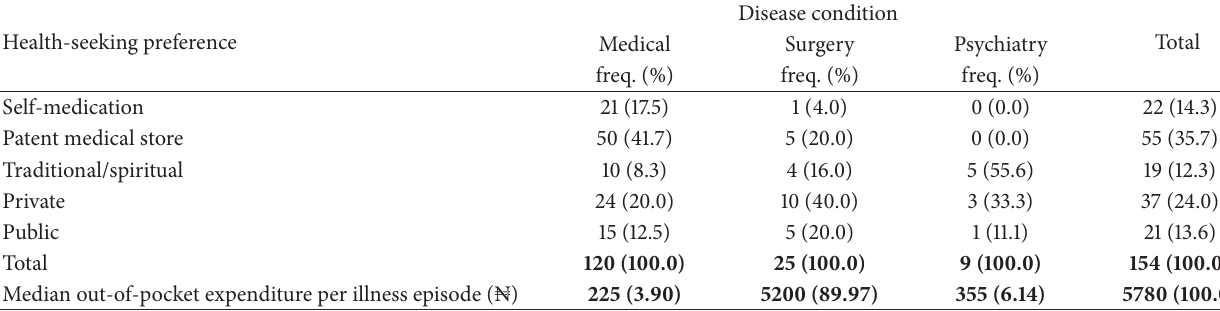
Table 3: Health-seeking preference by disease condition of respondents.